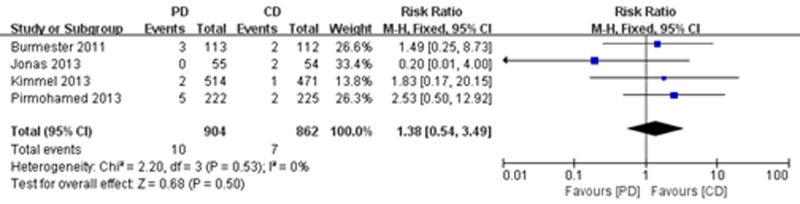
Forest plot of all-cause mortality.